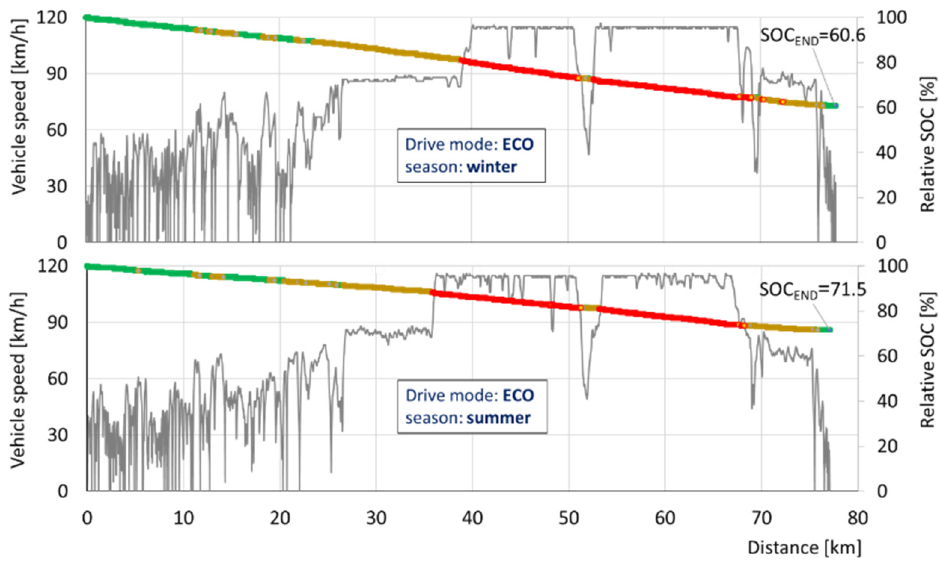
Figure 19. Comparison of the driving conditions (RDC) test for the performed test runs in winter and summer conditions.